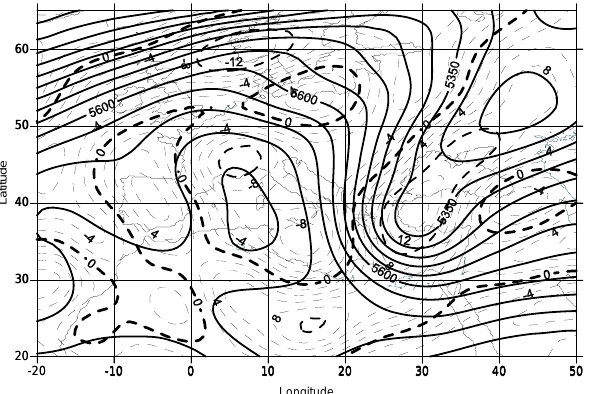
Fig. 6. Geopotential height (solid lines, gpm) over the 500hPa isobaric surface and relative vorticity (dashed lines, × 10 − 5 s − 1 ) over the 300hPa isobaric surface for the cluster “South”, at time D0.